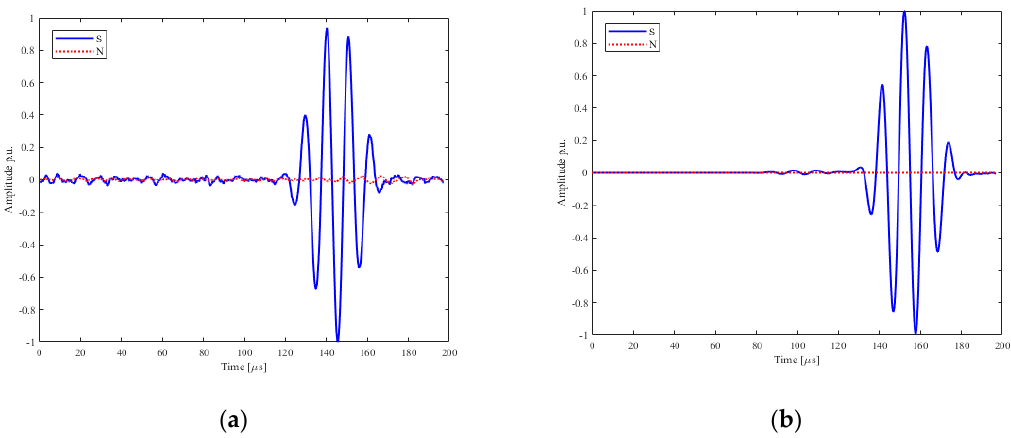
Figure 21. Configuration B results of the in-plane (blue), ‘S’, and out-of-plane, ‘N’, (red) velocities, experimental ( a ) and numerical ( b ) along the line orthogonal to the line of vibration. Amplitude and normalized data are shown.